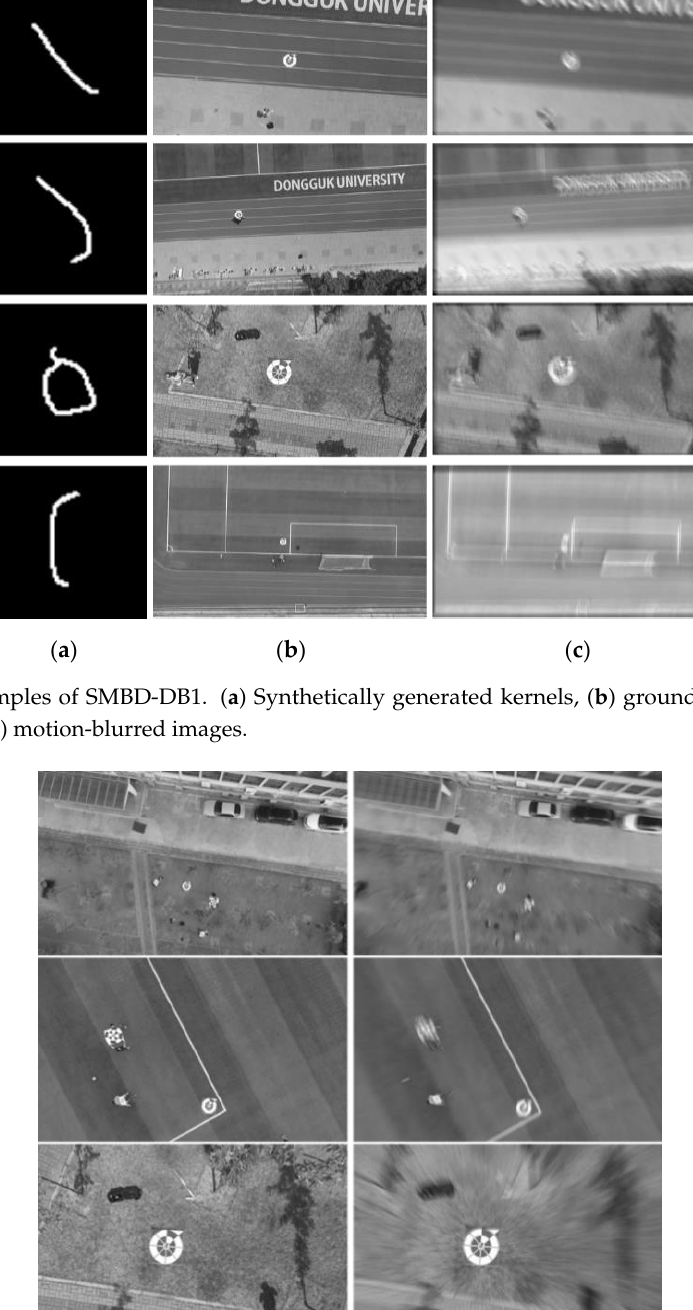
Table 5. Descriptions of RMBD-DB1. Sub-Dataset